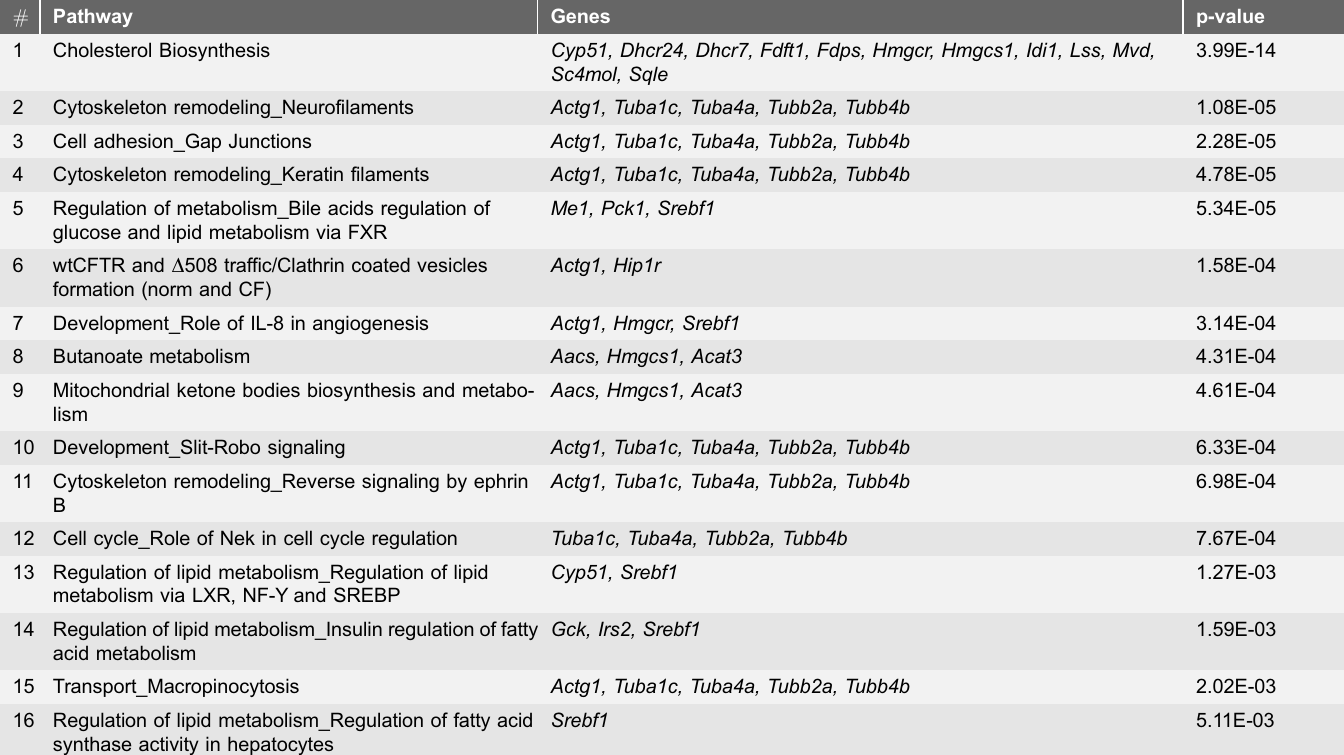
Table 2. GeneGO pathway map